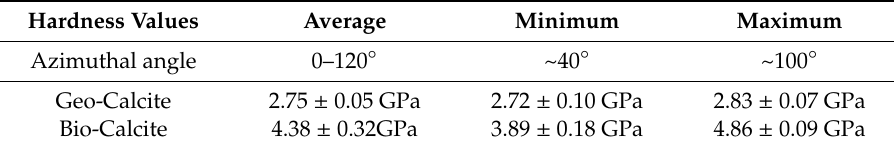
Table 1. Characteristic hardness parameters of geological and biogenic calcite as determined by conventional Berkovich nanoindentation (depth: 100 to 250 nm). Both calcite variants show a relatively high standard deviation in the averaged hardness value, which originates in the azimuthal angle dependent hardness. A minimum hardness was observed at an azimuthal angle of 40 ◦ and at maximum hardness at an angle of 100 ◦ .